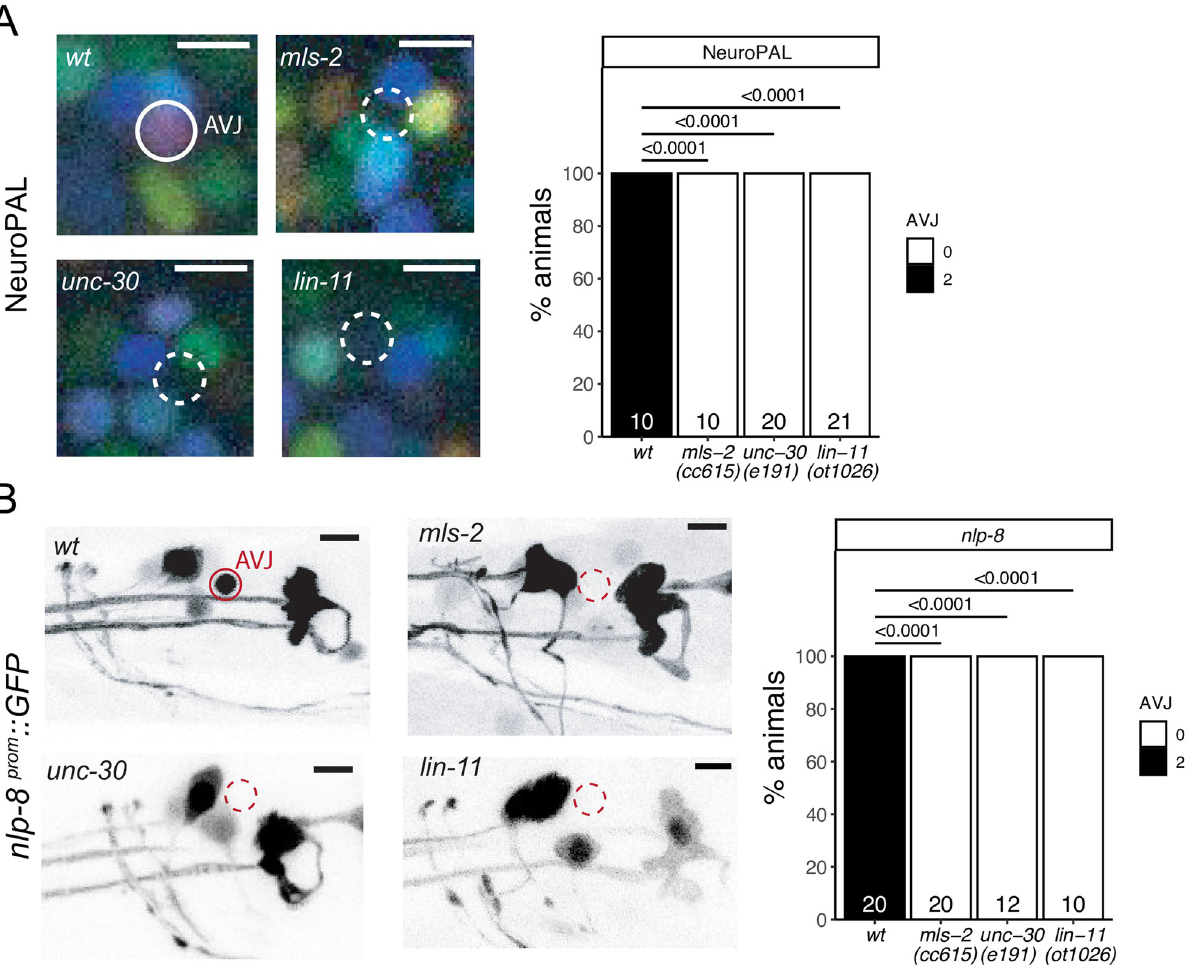
Fig 4. Three homeobox genes control the identity of the AVJ neuron class. Fig 4A: mls-2 (cc615) , unc-30 (e191) and lin-11(ot1026) mutant animals show defects in the expression of NeuroPAL ( otIs669 ) in AVJ. Neuron of interest is outlined in solid white when expressing wildtype reporter colors, and dashed white when one or all colors are lost. Representative images of wildtype and mutant worms are shown with 5 μ m scale bars. Graphs compare expression in wildtype worms with the number of animals examined listed at the bottom of the bar. P-values were calculated by Fisher’s exact test. Fig 4B: mls-2 (cc615) , unc-30 (e191) and lin-11(ot1026) mutant animals show defects in the expression of an nlp-8 reporter transgene ( otIs711 ) in AVJ. Neuron of interest is outlined in solid red when expressing wildtype reporter colors, and dashed red when one or all colors are lost. Representative images of wildtype and mutant worms are shown with 5 μ m scale bars. Graphs compare expression in wildtype worms with the number of animals examined listed at the bottom of the bar. P-values were calculated by Fisher’s exact test.